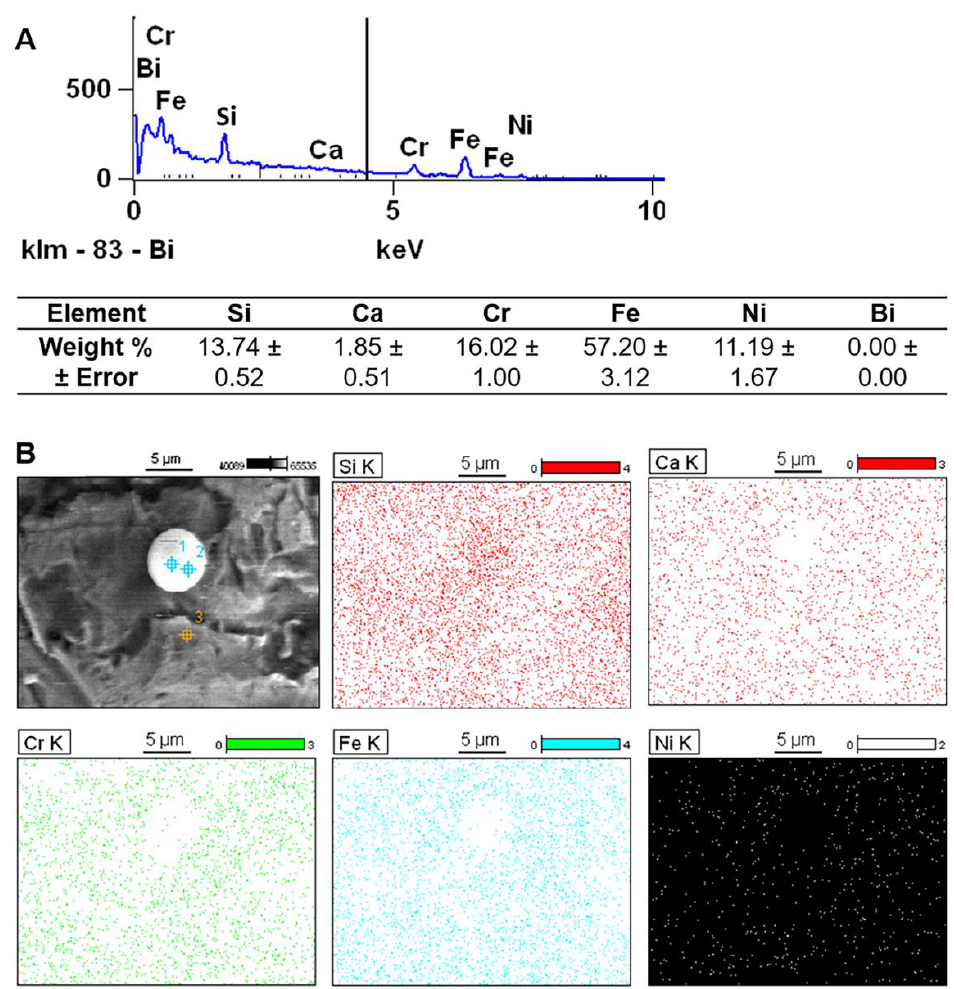
Figure 11. ( A ) Energy dispersive X-ray (EDX) analysis of the residual particles at locations 1 and 2 (location 3 was measured for reference). ( B ) X-ray mapping showing the elemental distribution in the region of the spherical particle.